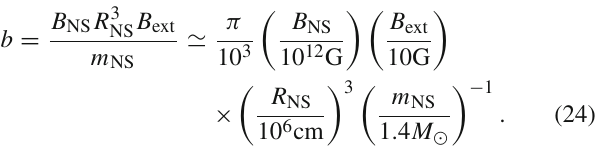
Fig. 6 Radial dependence of effective potential for the radial motion of magnetized particles around electrically charged BHs in EMS the- ory immersed in an external magnetic field at various values of the parameters γ,β and